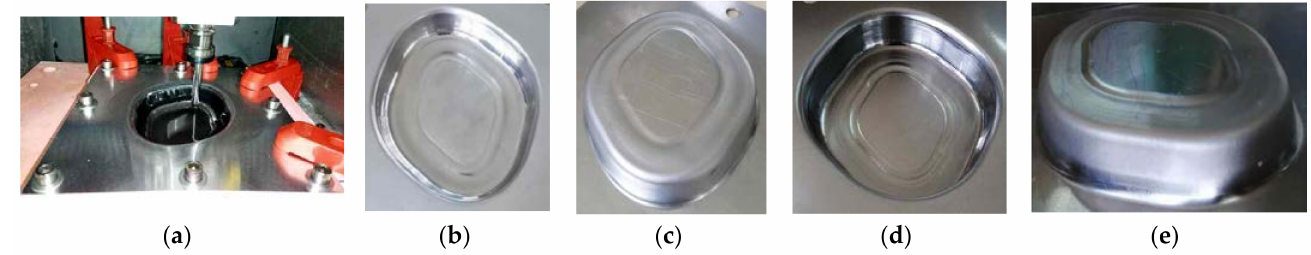
Figure 19. The proposed multi-stage forming: ( a ) the forming process, ( b ) the forward view of the straight wall part ( ψ = 5 ◦ ), ( c ) the reverse view of the straight wall part ( ψ = 5 ◦ ), ( d ) the forward view of the straight wall part ( ψ = 15 ◦ ), and ( e ) the reverse view of the straight wall part ( ψ = 15 ◦